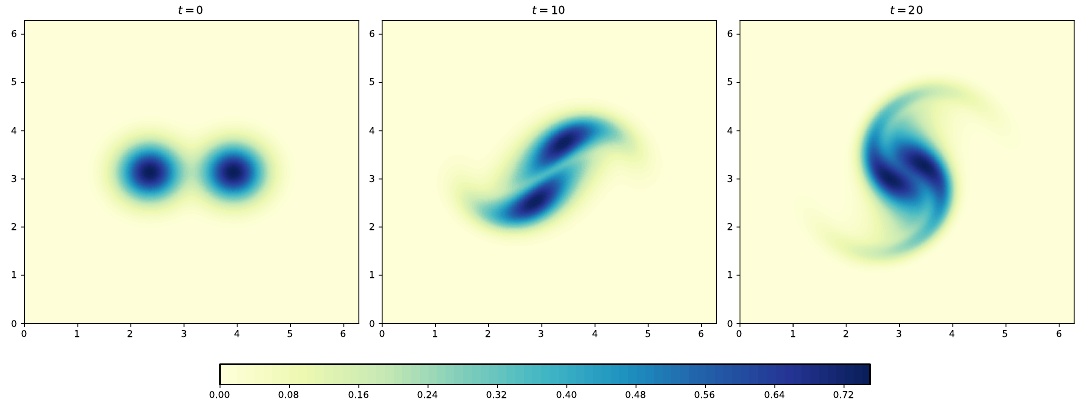
Figure 26. Evolution of the vorticity field at three time steps during the co-rotating vortex interaction. The solution is computed using second-order explicit